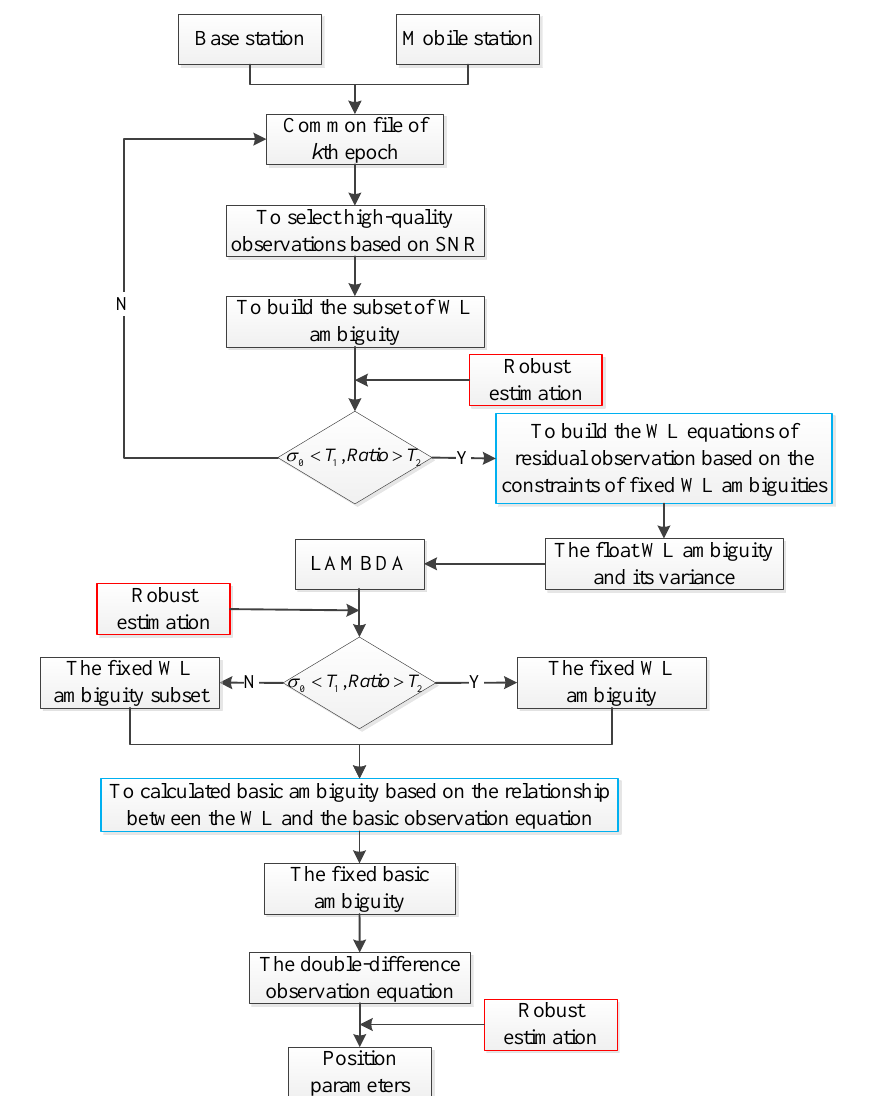
Figure 2. Process flow of the proposed method.